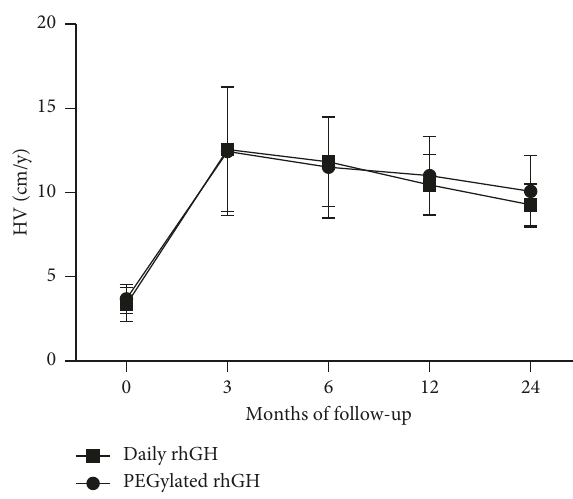
Figure 1: Temporal trend in HV over time in GHD children treated with PEGyated rhGH (weekly) or daily rhGH (daily) for 24months. Values represent mean ± SD.